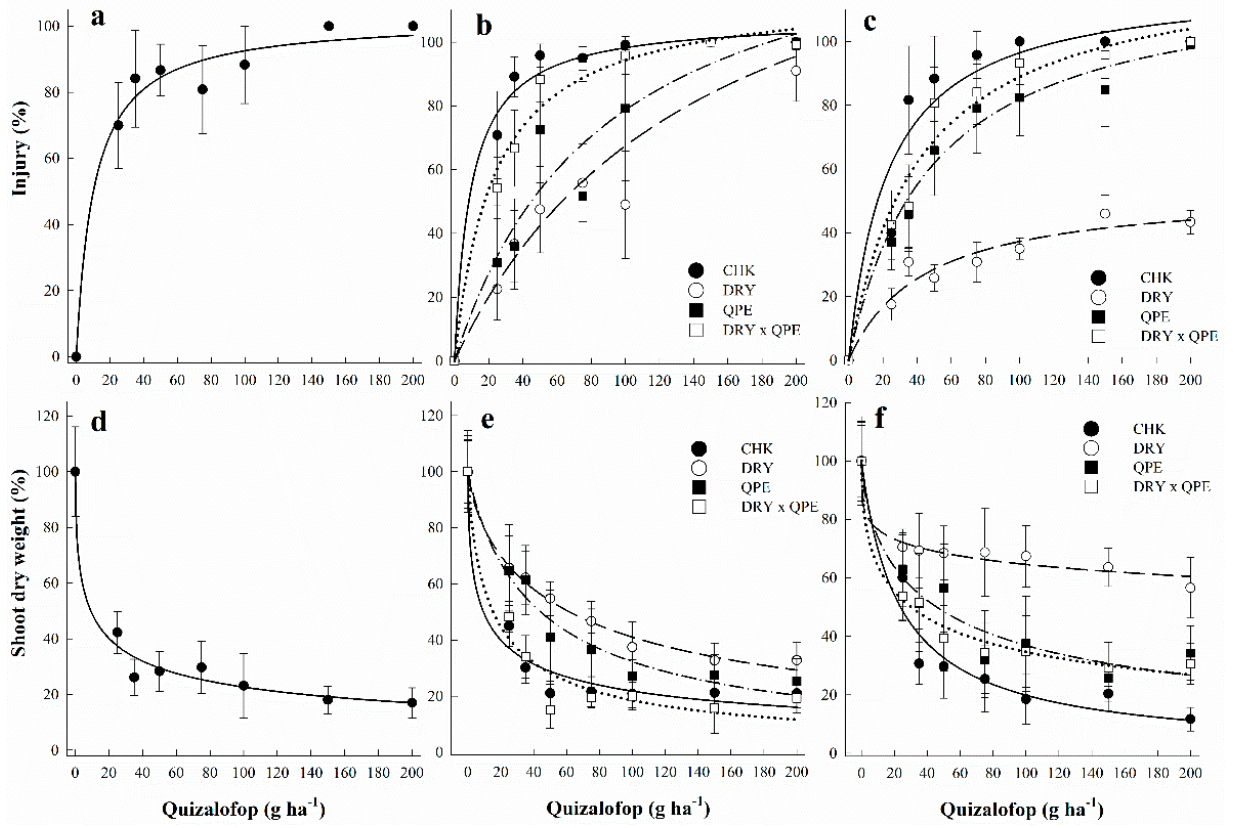
Figure 2. Visual injury and shoot dry weight of Eragrostis plana populations from generations G 0 ( a , d ), G 1 ( b , e ), G 2 ( c , f ) at 35 DAA of quizalofop-p-ethyl doses. Populations: no stress (CHK), drought (DRY), quizalofop (QPE), and drought × quizalofop (DRY × QPE). Parameters estimated for the curves are presented in Table 2. Error bars represent a 95% confidence interval. To run the dose-response curves, no stress was applied to the plants.